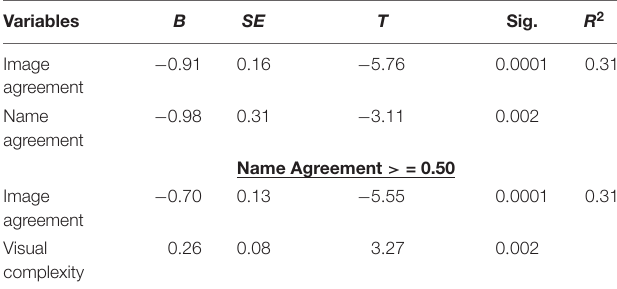
TABLE 4 | Step-wise regression with ToT as a dependent